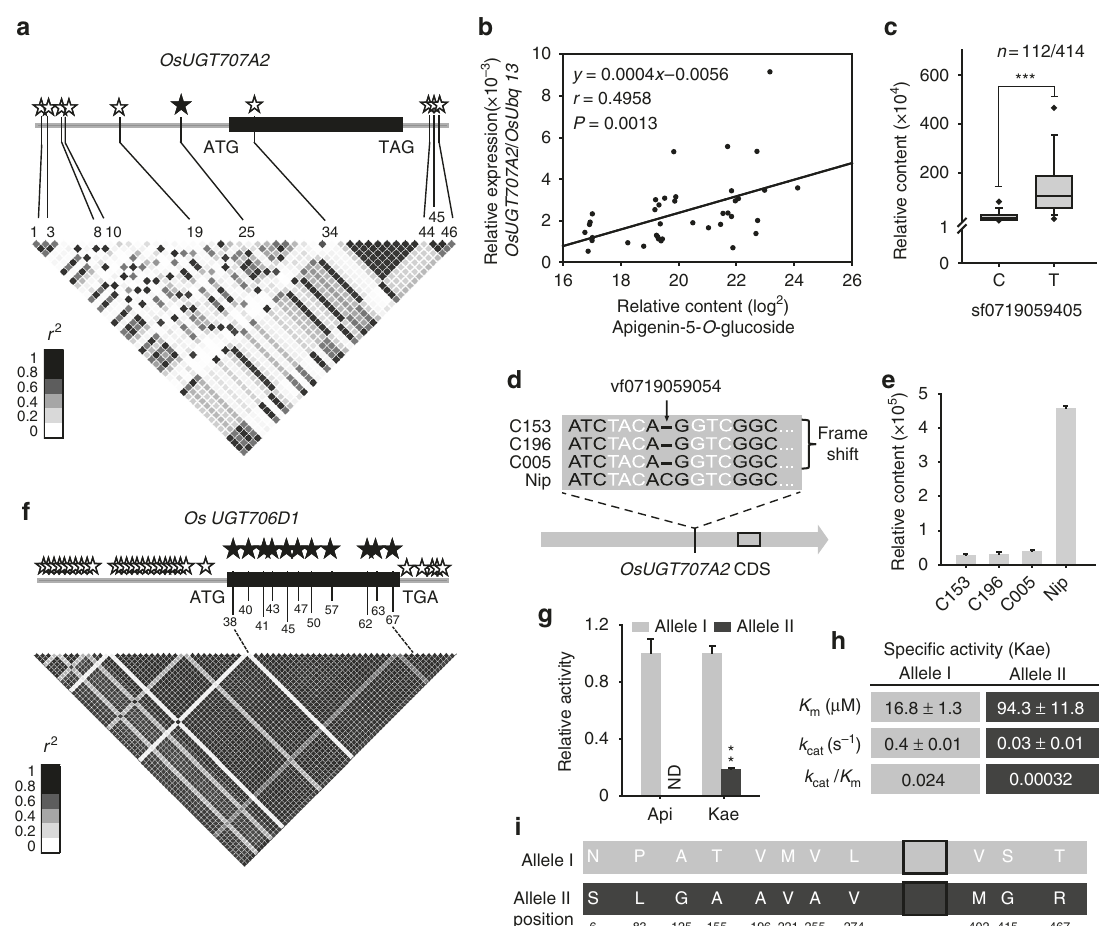
Fig. 3 Analyses of functional SNPs within OsUGT707A2 and OsUGT706D1 . A representation of the pairwise r 2 value (a measure of linkage disequilibrium) among polymorphic sites in OsUGT707A2 ( a ) and OsUGT706D1 ( f ), where the darkness of the box corresponds to the r 2 value according to the legend. Stars represent the signi fi cant sites identi fi ed in UGT707A2 ( P < 8 × 10 – 33 ) and UGT706D1 ( P < 2 × 10 – 19 ), and solid stars indicate the functional SNPs. The P value is calculated using the Student ’ s t tests. b Correlation between relative contents of apigenin 5- O -glucose and transcript levels of OsUGT707A2 in 39 rice varieties. c Box plot for the content of apigenin 5- O -glucoside; plotted as an associated site at Chromosome 7. sf0719059405. *** P < 0.001, Student ’ s t tests. d Alignment of partial nucleotide sequences of OsUGT707A2 from different rice varieties. C153, C196 and C005 indicate three rice varieties that originated in china, respectively. e Comparison of the content of apigenin 5- O -glucoside in different rice varieties. The data are presented as mean ± SD, n = 3. g Enzymatic activity of OsUGT706D1 from two alleles. Allele I indicates the high producer genotype whereas the allele II indicates the low producer genotype. Assay was repeated three times and bars indicate mean ± SD, n = 3. ** P < 0.01, Student ’ s t tests. h Kinetic parameters of OsUGT706D1 from two alleles. The data are presented as mean ± SD from two replicate independent assays. i Alignment of full amino acid sequences of OsUGT706D1 from two alleles. Black block indicates the conserved PSPG box domain. Nip nipponbare, ND not (Supplementary Fig. 5 and Supplementary Table 1). Five UGTs were identi fi ed to be active on both fl avone (apigenin) and fl